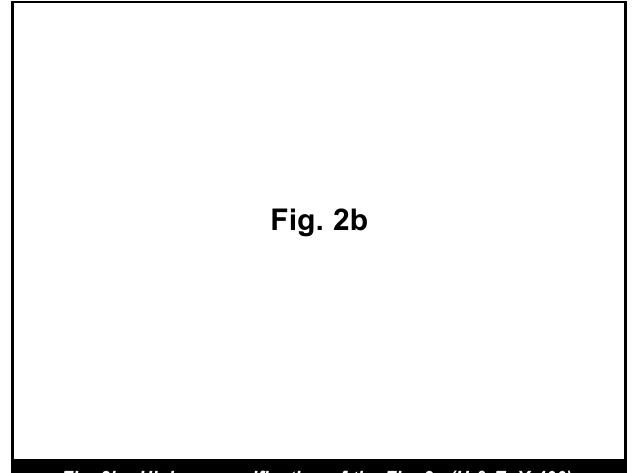
Fig. 2b : Higher magnification of the Fig. 2a (H & E; X 400).